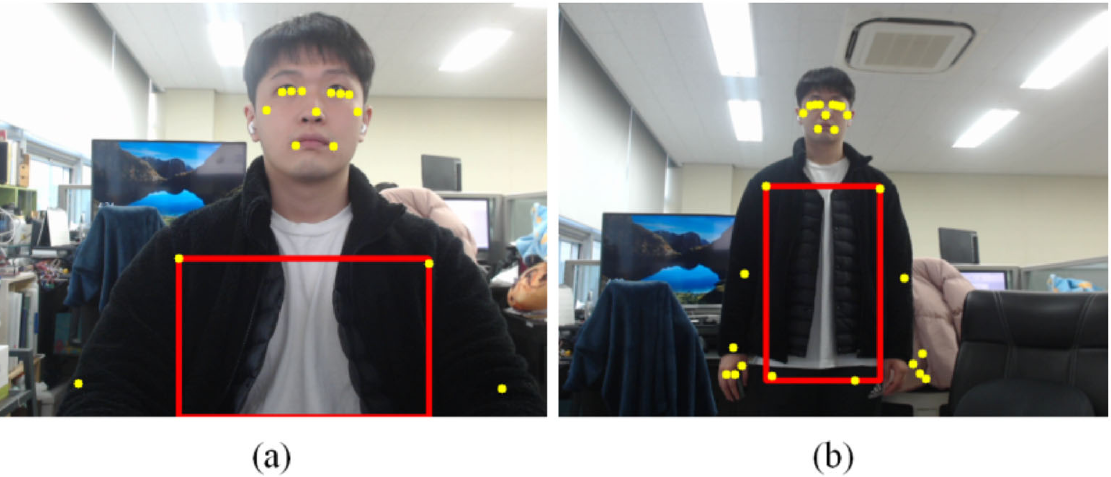
Figure 4. Example of chest RoI detection results based on body landmark point: ( a ) if only a portion of the chest area is in the image; ( b ) if all the chest area is in the image.